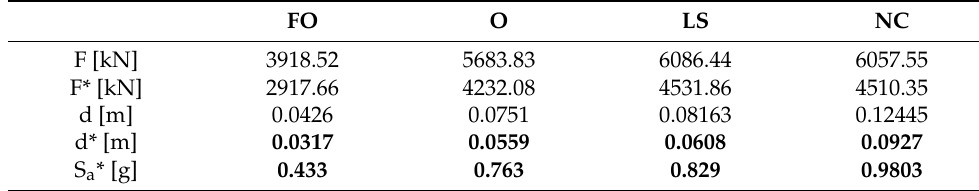
Table 4. ADRS spectrum approach (GCBF).